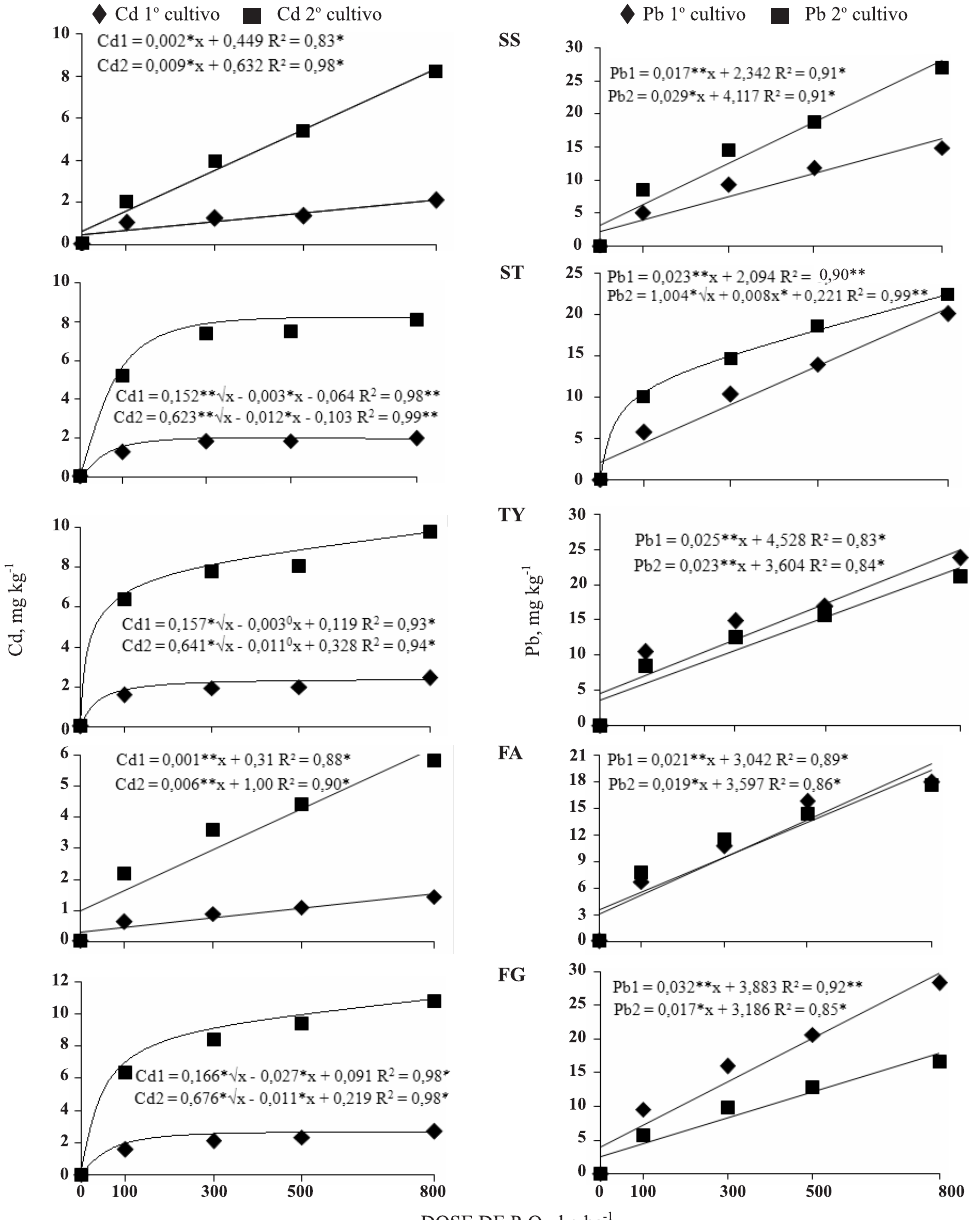
Figura 1. Teores de Cd e Pb na parte aérea das plantas de milho em dois cultivos sucessivos em função das doses dos fertilizantes superfosfato simples (SS), superfosfato triplo (ST), termofosfato Yoorin (TY), fosfato natural de Araxá (FA) e fosfato natural de Gafsa (FG) . **, * e o : significativos a 1, 5 e 10 %,